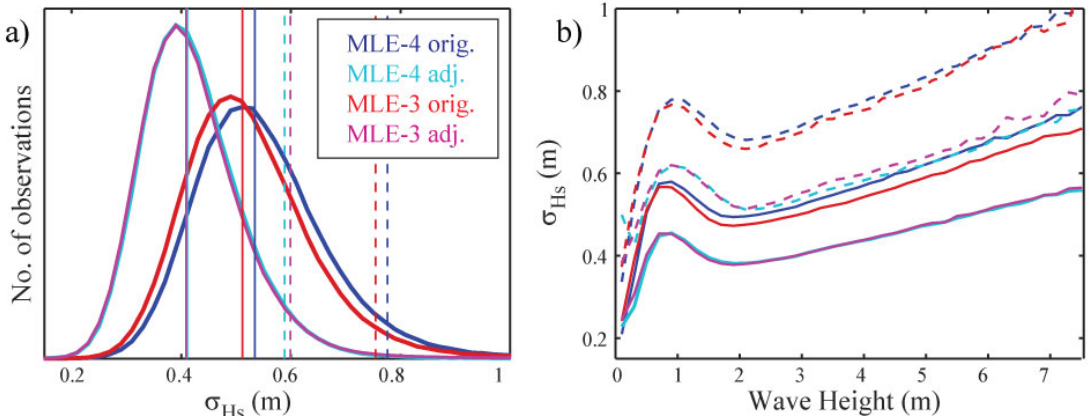
Figure 6. Distribution of σ Hs values from 300 pole-to-pole tracks of Jason-3. ( a ) Histograms of all 1 Hz values, with vertical lines indicating the position of the median (solid line) and 95th percentile (dashed line). ( b ) Variation of median (solid lines) and 95th percentiles (dashed lines) as a function of Hs.